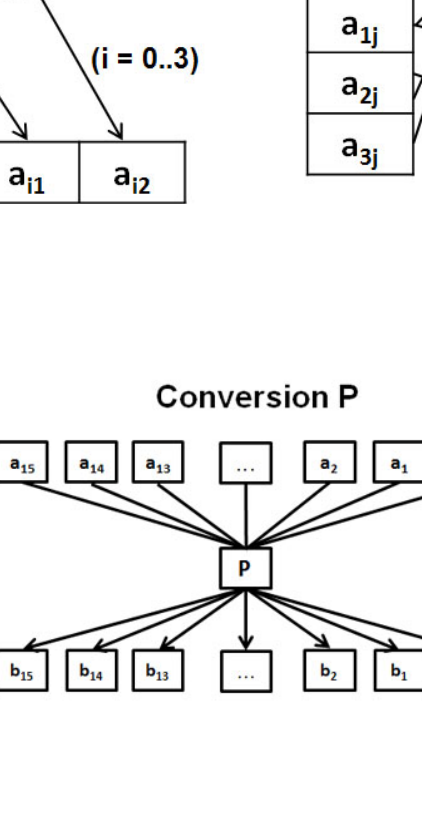
Table 1: Examples of the avalanche effect